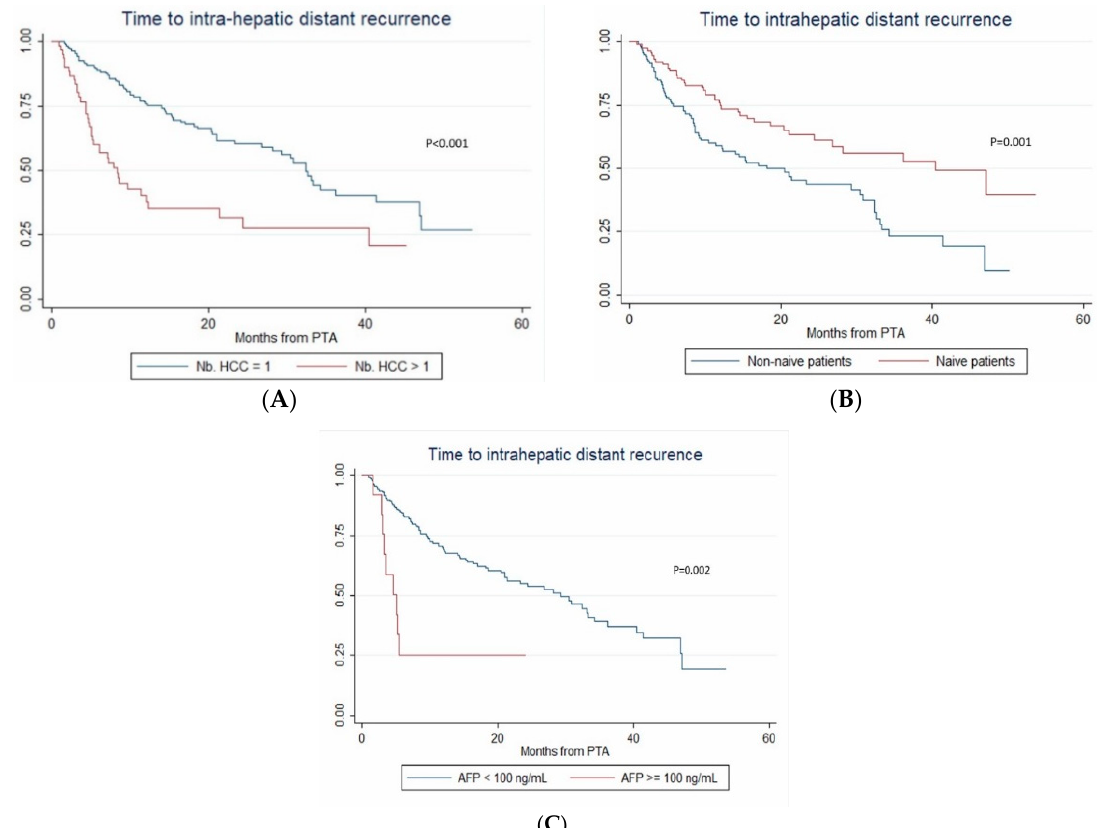
Figure 3. In patients with uninodular vs. multinodular HCC ( A ), in treatment-naïve vs. non-treatment naïve patients ( B ), and in patients with alpha fetoprotein (AFP) < 100 ng/mL vs. AFP ≥ 100ng/mL ( C ) (Kaplan–Meier analyses).